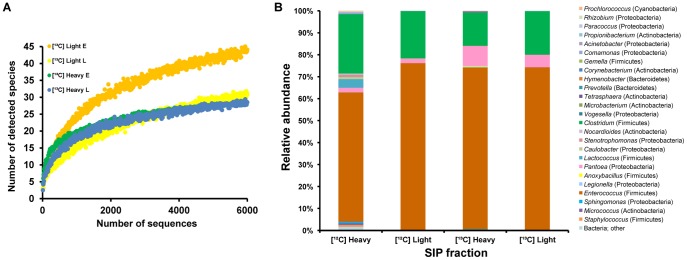
Bacterial diversity and relative abundance in the gut microbiota of late-instar larvae.(A) Rarefaction curves of 16S rDNA sequences were obtained from representative SIP fractions of early-instar and late-instar larvae. Abbreviations: E, representative fractions from early-instar larvae fed on 13C-glucose; L, fractions from late-instar larvae fed on 13C-glucose. (B) Relative abundance of bacterial taxa in different SIP fractions, represented in a relative area graph as revealed by pyrosequencing. Abbreviations are the same as in Fig. 3.